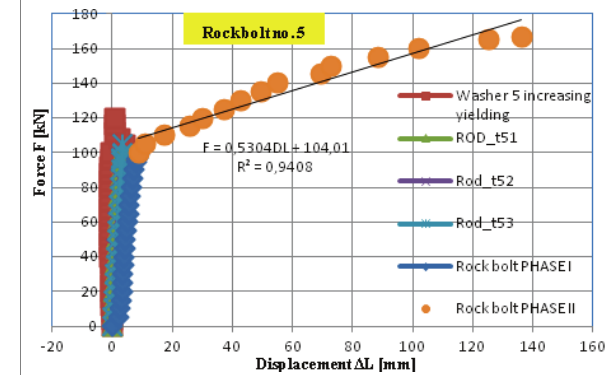
Fig. 24. The full loading characteristics for bolt No. 4 with the deformable component